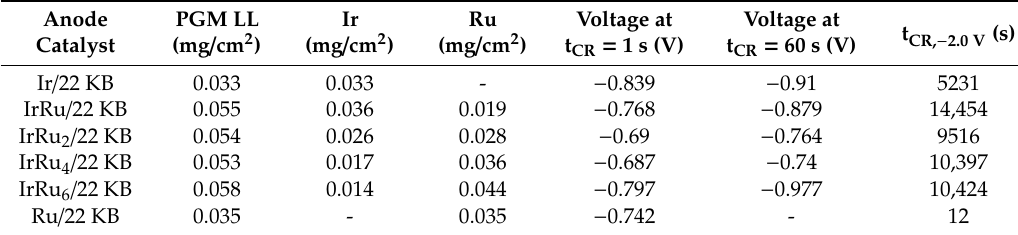
Figure 3. Voltage–time (V–t) plot of Ir/22 KB, IrRu/22 KB, IrRu 2 /22 KB, IrRu 4 /22 KB, IrRu 6 /22 KB and Ru/22 KB anode MEAs ( a ) within initial 100 s during the cell reversal test and ( b ) during the whole experimental period. Table 2. Results of cell reversal test using anodes prepared with Ir, Ru and their alloy